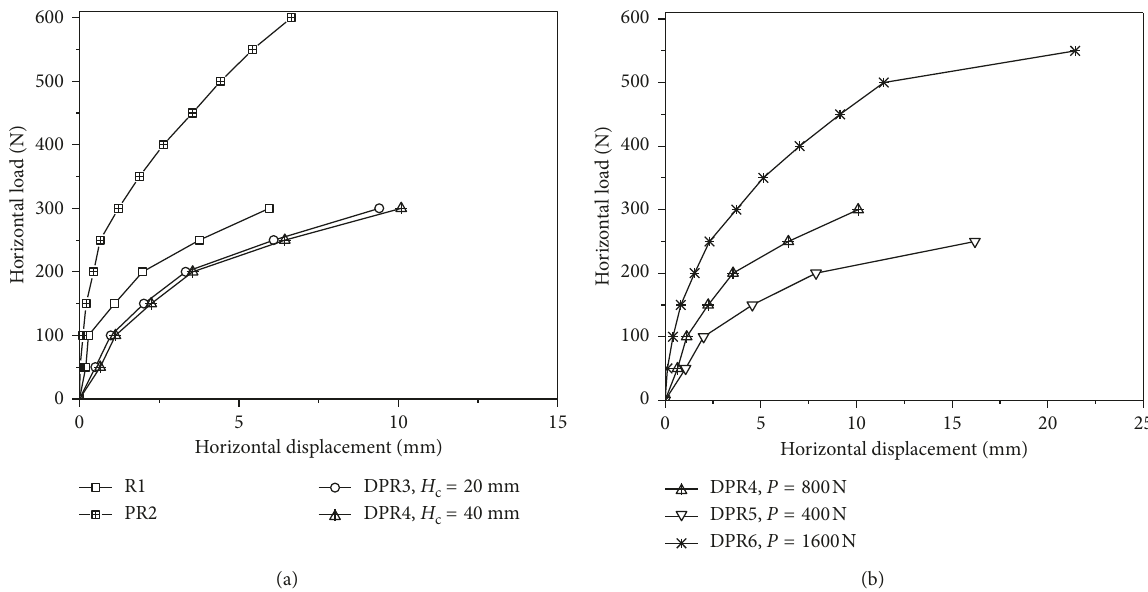
Figure 6: Horizontal load versus horizontal displacement of the raft foundations. (a) The influence of the connection condition between the raft and piles. (b) The influence of the vertical load on the DPR.